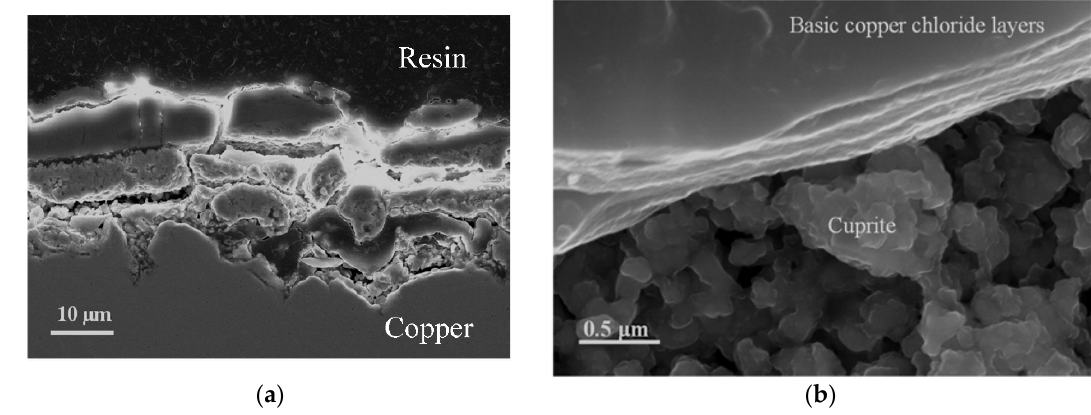
Figure 8. Piling of the basic copper chloride layers on the innermost cuprite layer. Cross section ( a ) and surface ( b ) views.